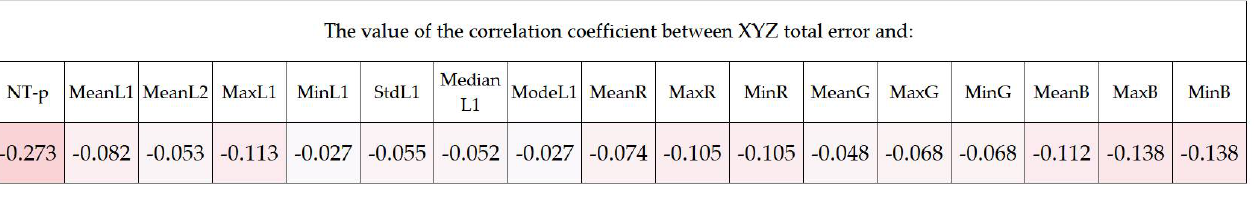
Figure 16. The value of the correlation coefficient between XYZ total error and the F-point features.